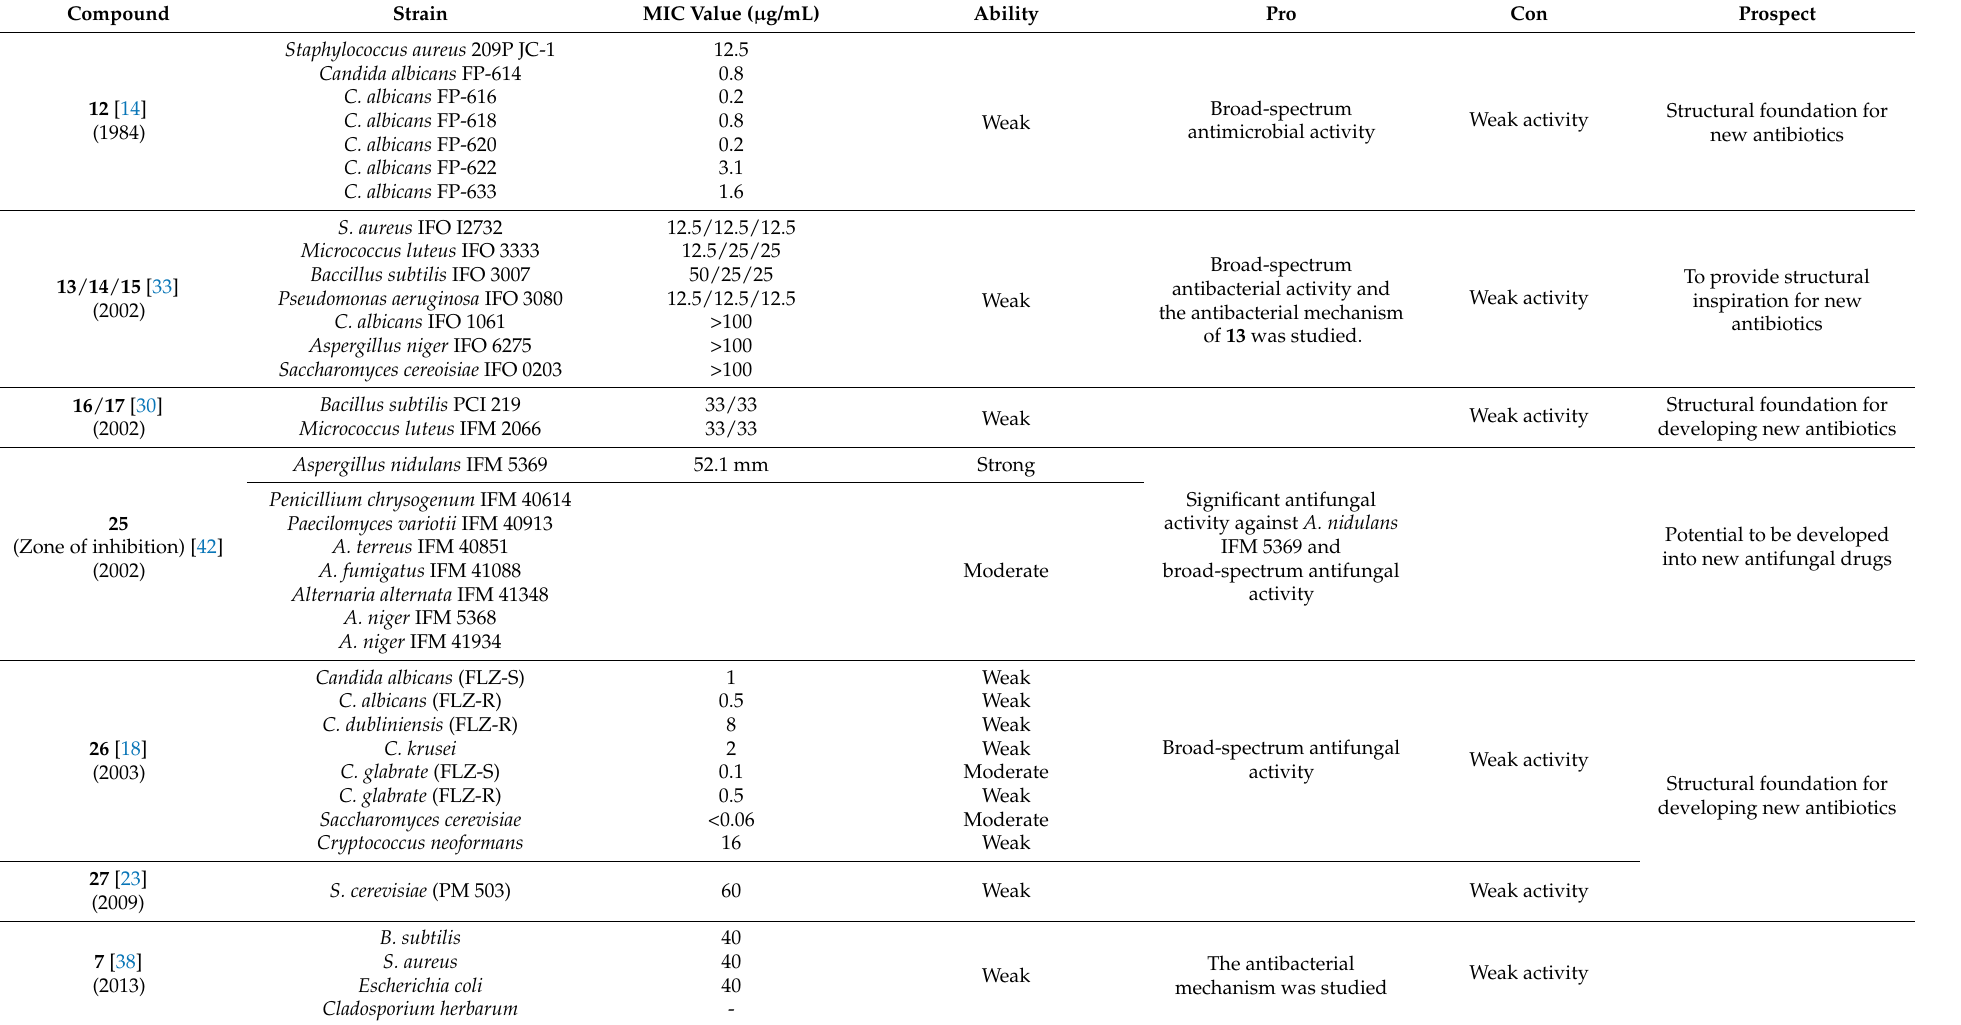
Table 2. Compounds with antimicrobial